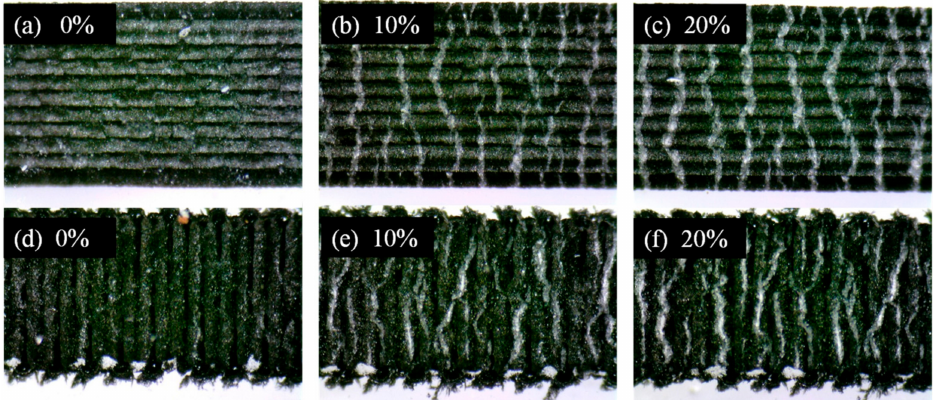
Figure 11. Digital microscope images of ( a – c ) parallel and ( d – f ) vertical LIG structures for applied strain values of 0%, 10%, and 20%,